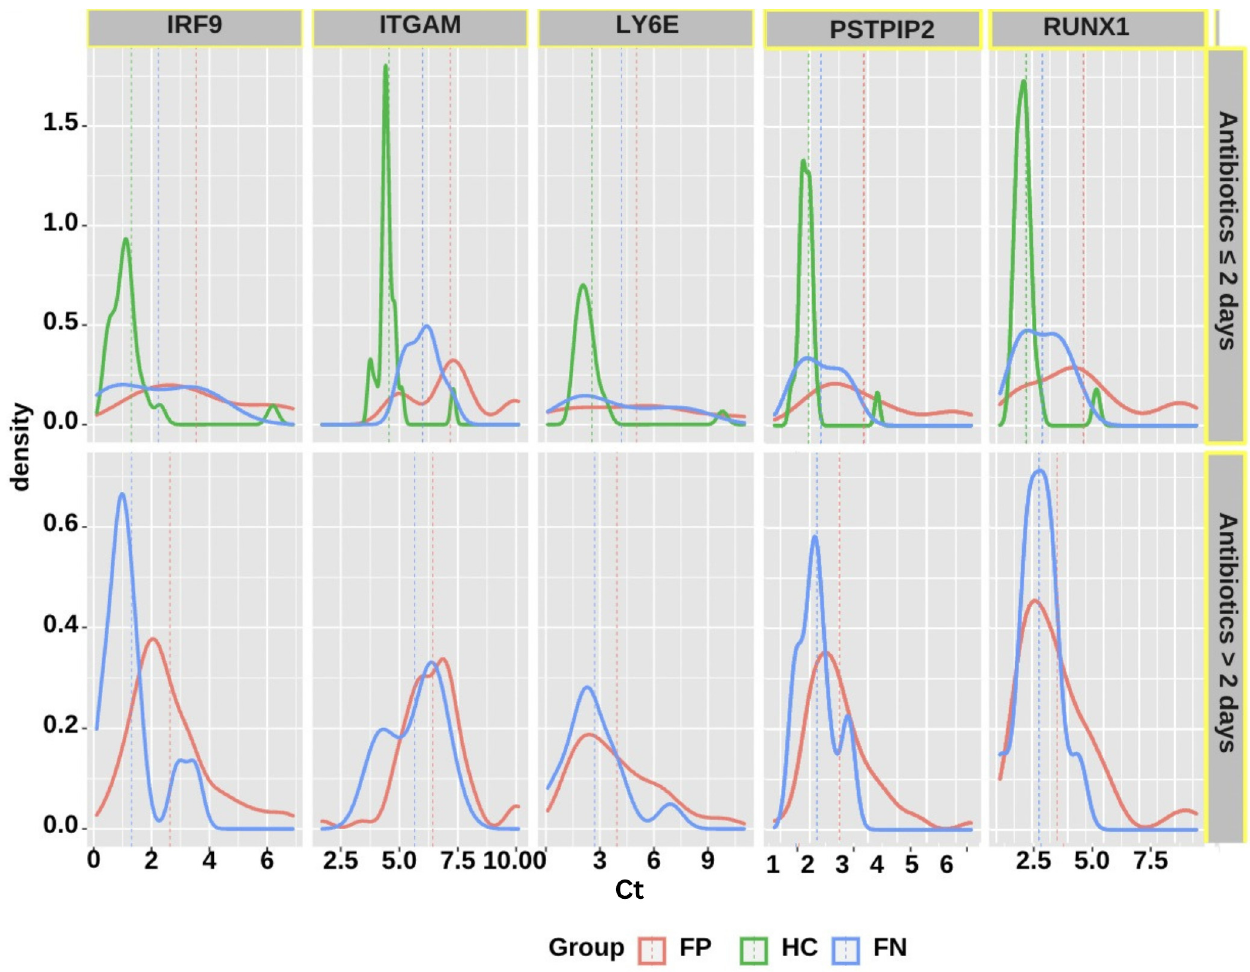
Figure 6. Density plots displaying distributions of the five genes in the FP, FN, and HC groups classified by antibiotic duration status.